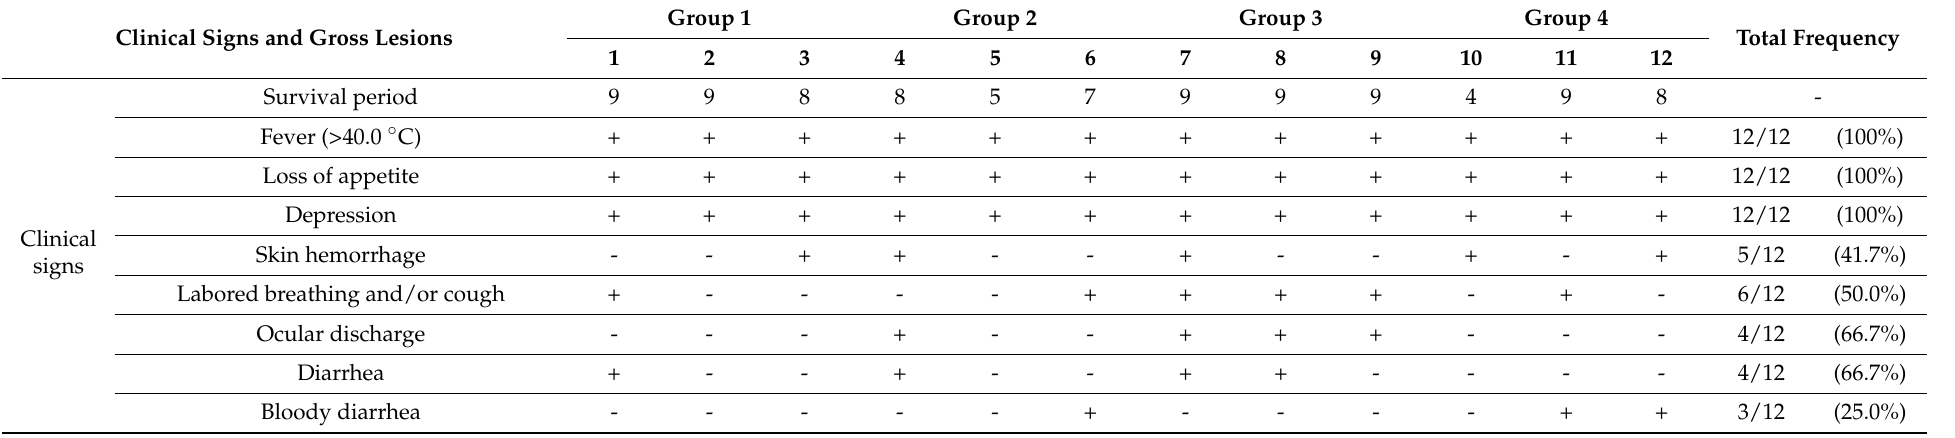
Table 2. Summary of clinical signs and gross lesions in pigs inoculated with four Korean ASFV